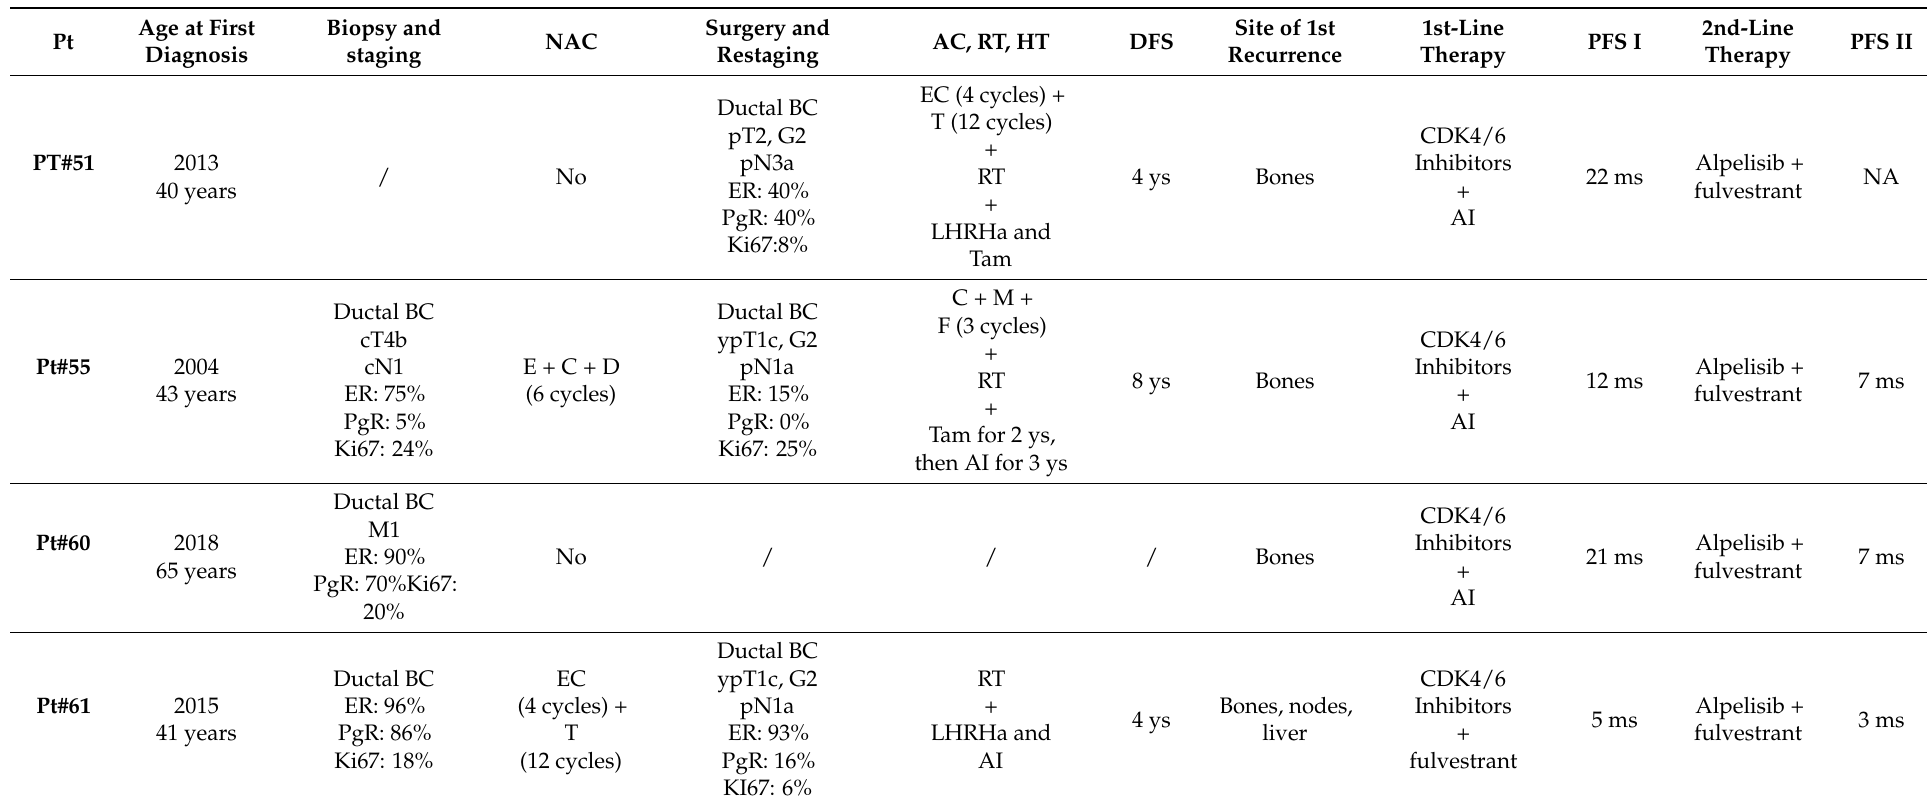
Table 1. Patient characteristics: tumor biological features and therapy